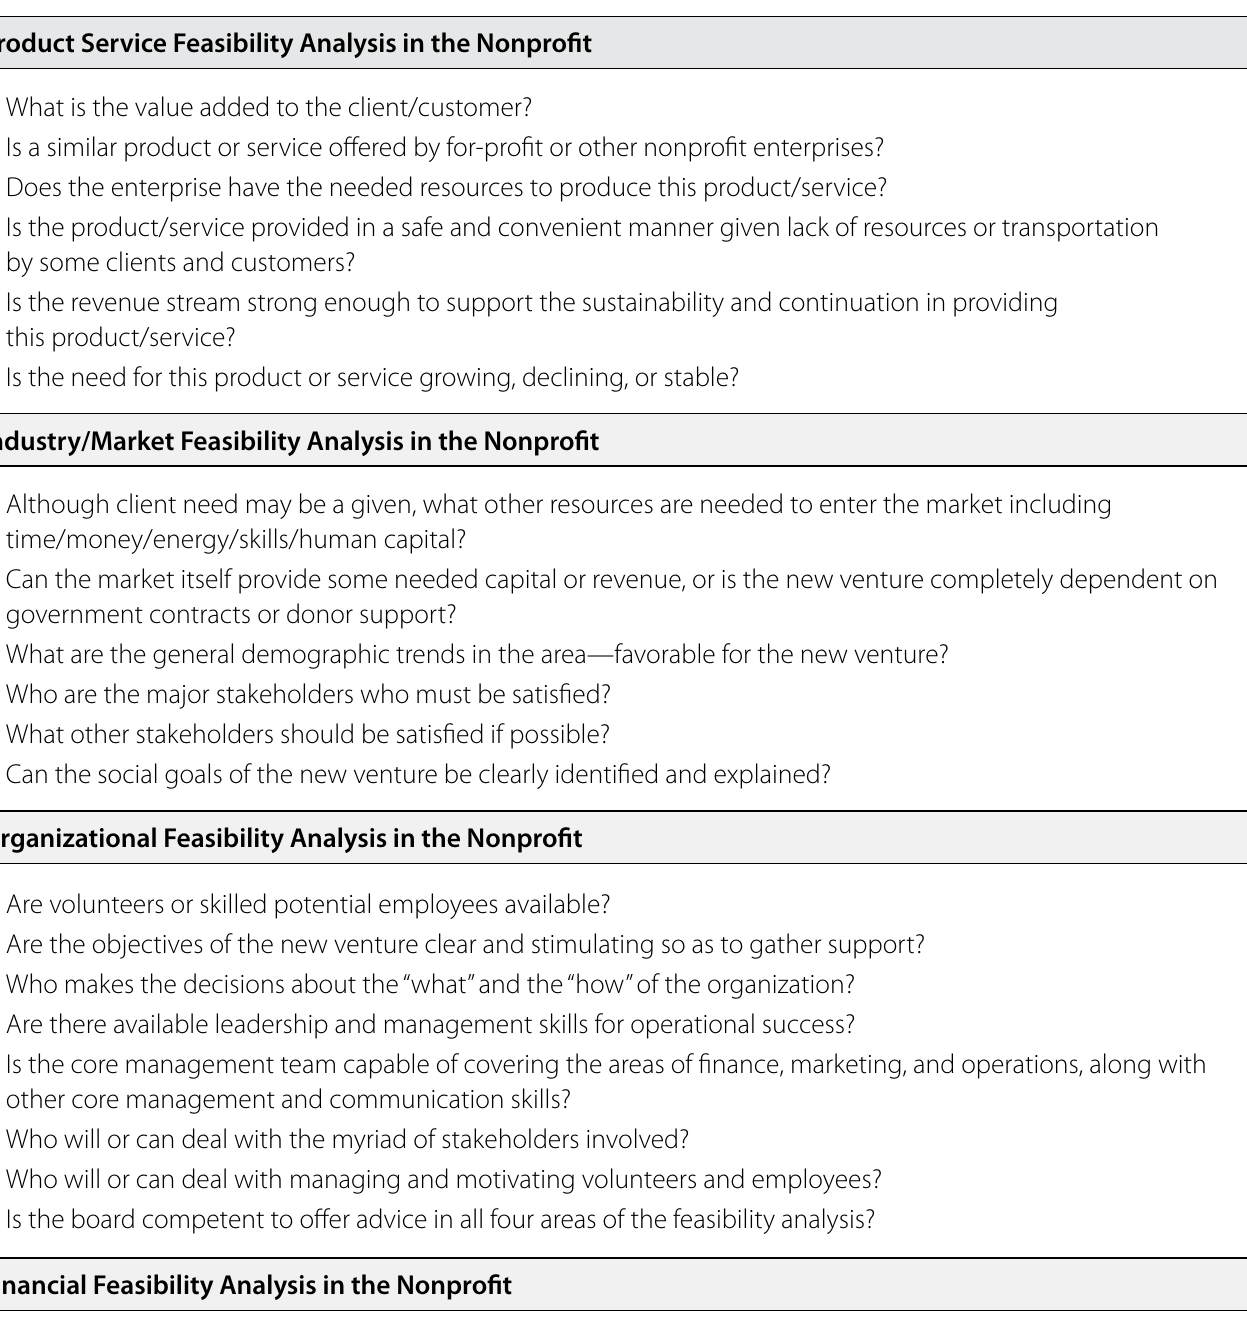
Table 4. Questions Asked During Feasibility Analysis for a New Venture